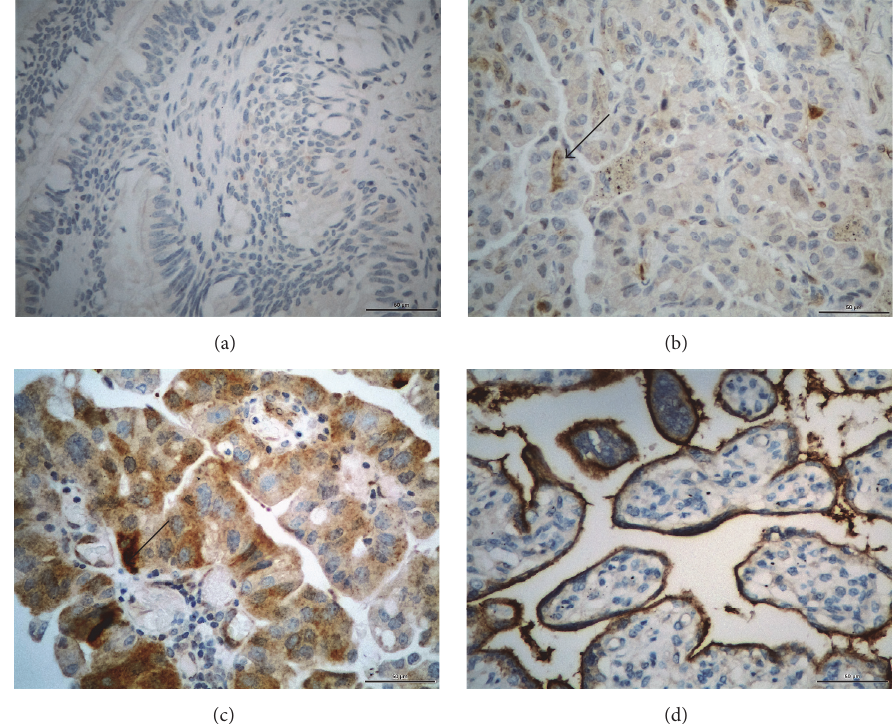
Figure 1: Photomicrographs of PD-L1 immunohistochemical expression in lung cancer tumor cells (magnification/scale bar: 400x/50 𝜇 ). (a) Absence of PD-L1 expression; (b) negative PD-L1 expression ( < 5% of stained cells); (c) positive PD-L1 expression ( ≥ 5% stained cells); (d) Positive Control with placental tissue. Arrows show positive staining cells.